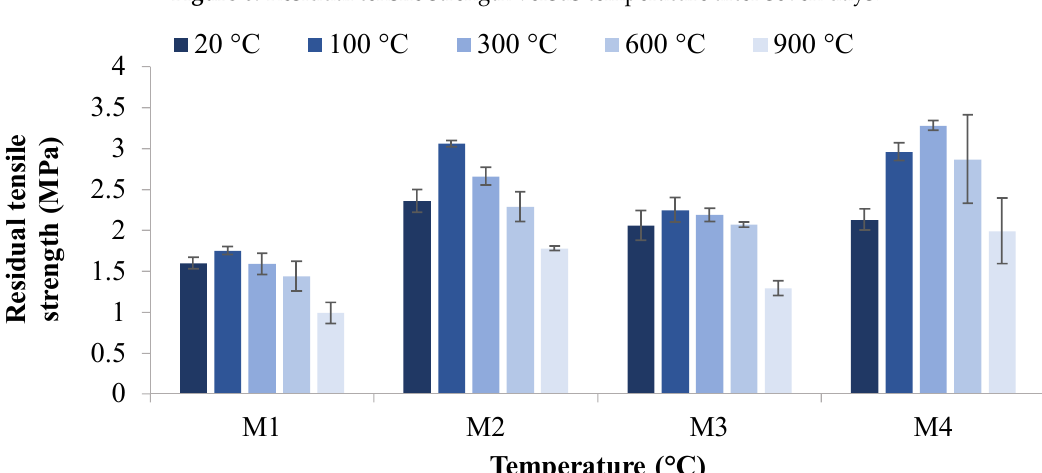
Figure 7. Residual tensile strength versus temperature after 28 days.